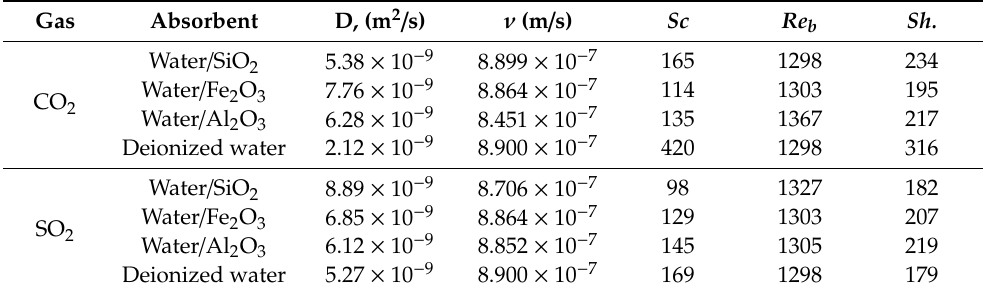
Table 4. Diffusion coefficient as well as Re , Sh and Sc for CO 2 and SO 2 absorption by using of nanofluids.